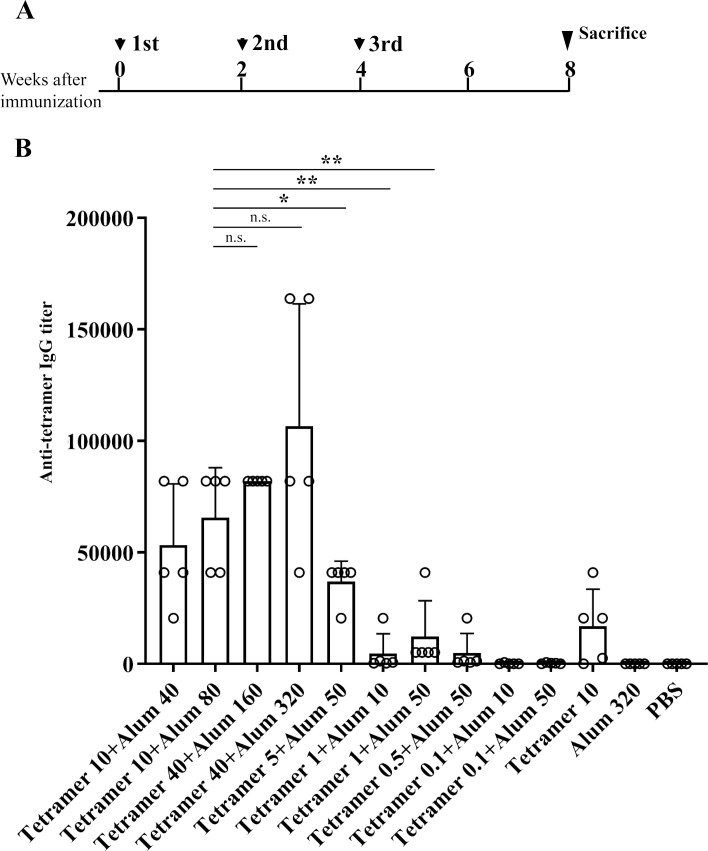
Humoral immunity induced by immunization with different amounts of the tetramer and Alum.(A) Immunization schedule indicated as the weeks from the fist immunization of the four-week-old female BALB/c mice (n = 5). (B) The amounts of the anti-tetramer antibodies in the sera collected from the immunized mice at the eight weeks after the third immunization as indicated in (A) were evaluated by the ELISA assay using purified tetramer as the antigen. The titers were calculated as the maximum dilution at which the value of OD405 was higher than that of the mean+2SD of the group immunized with PBS. *p<0.05, **p<0.01 by Student's t-test. n.s.: not significant.